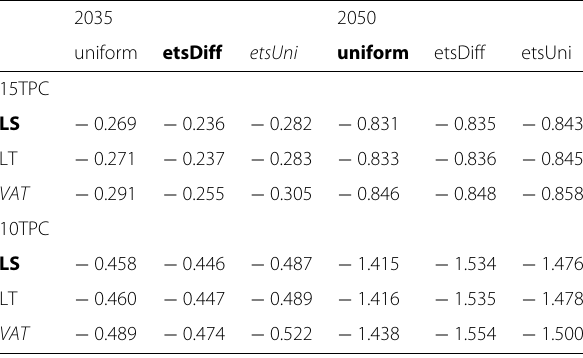
Table 7 Percentage change of MEI from BAU for different years and